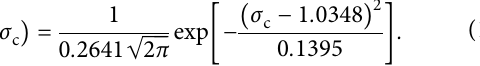
Figure 5: Schematic diagram of a soil-pile interaction